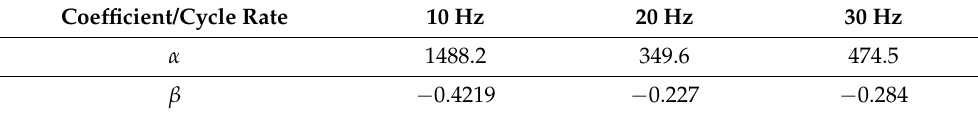
Table 5. Calculated values of α and β for the PLA material and given cycle rates.